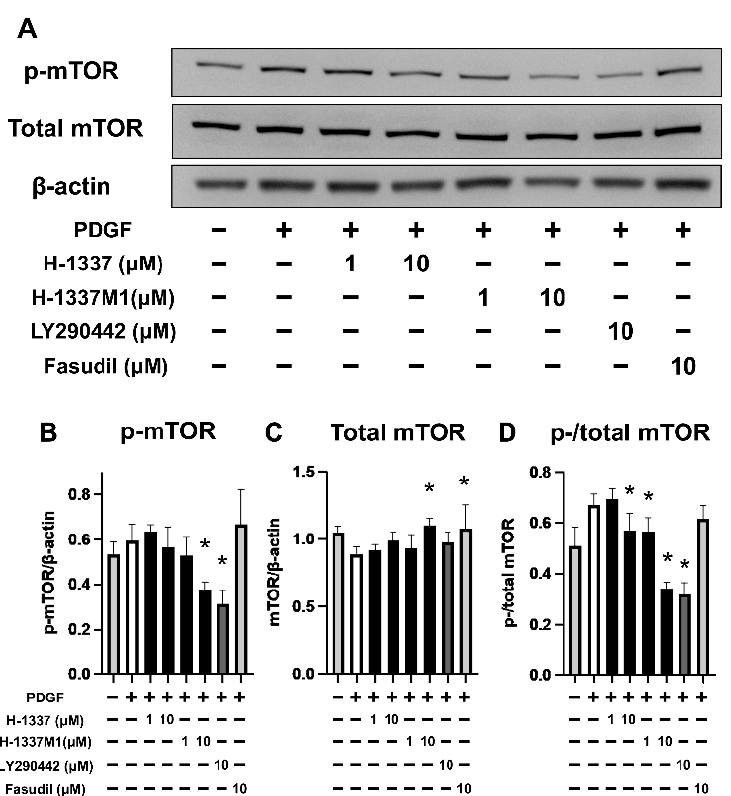
Figure 3. Phosphorylation of the Akt/mammalian target of rapamycin (mTOR) pathway in human pulmonary artery smooth muscle cells (hPASMCs). hPASMCs were treated with H-1337, H- 1337M1, fasudil (ROCK inhibitor), or LY294002 (phosphatidylinositol 3-kinase inhibitor) for 1 h, followed by stimulation with platelet-derived growth factor (PDGF; 10 ng/mL) for 1 h. ( A ) Repre- sentative photographs of western blots. ( B – D ) Quantification of the data from ( A ). ( B ) Mammalian target of rapamycin (mTOR). ( B ) Phosphorylated mTOR (p-mTOR). ( C ) mTOR. ( D ) The ratio of phospho- to total mTOR. *: analyzed by ANOVA, p < 0.05 versus groups treated with PDGF without H-1337, H-1337M1, fasudil, or LY294002.